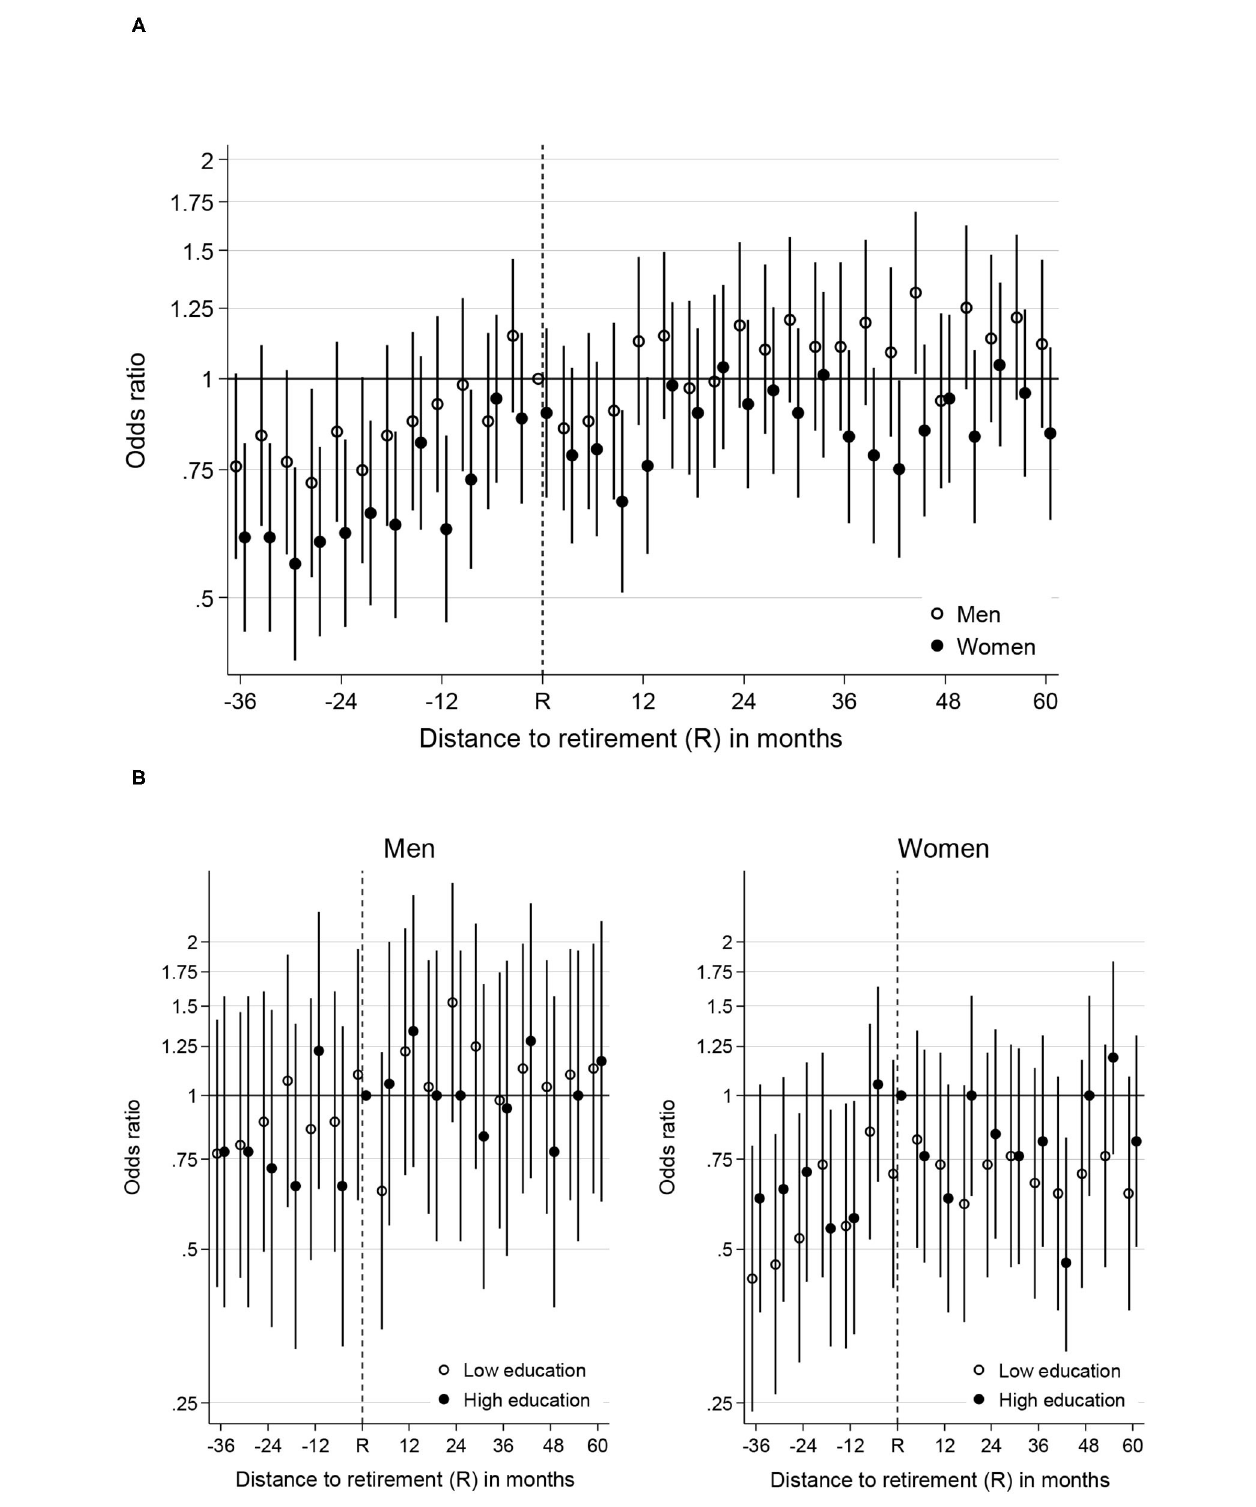
FIGURE 2 | (A) Likelihood of hospitalisation (expressed as odds ratio) during the retirement transition for men and women. Reference category is recently retired men. (B) Likelihood of hospitalisation (expressed as odds ratio) over the retirement transition by gender and education. Reference category is recently retired high educated men or women. Only data from the low and high education groups and every second measurement occasion are displayed.